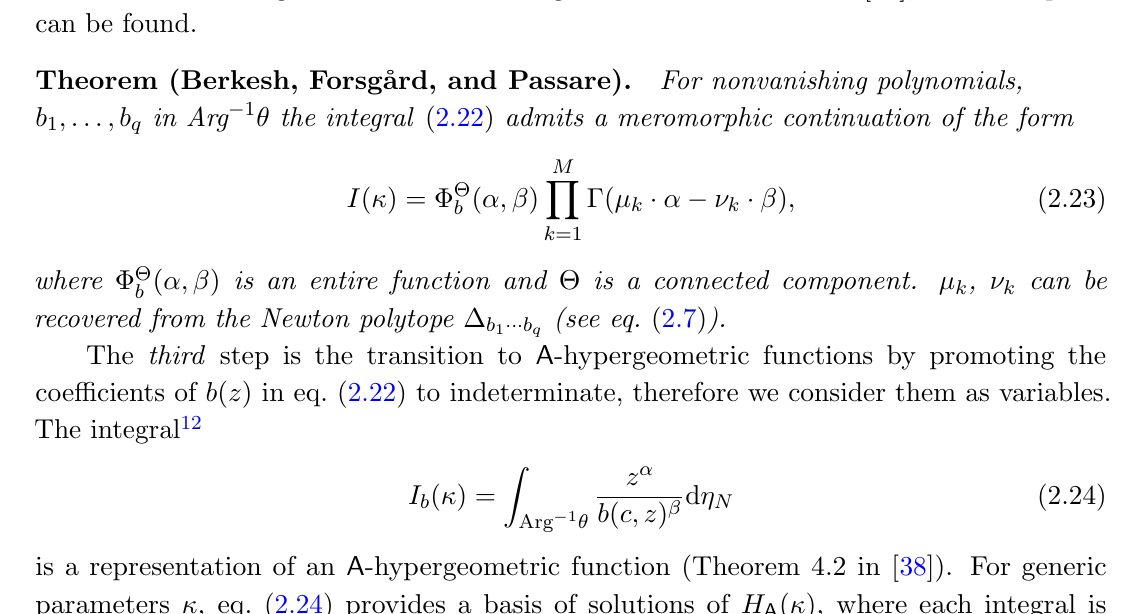
+ z 2 z 2 + c 4 z 2 z 2 drawn in the 2 1 2 1